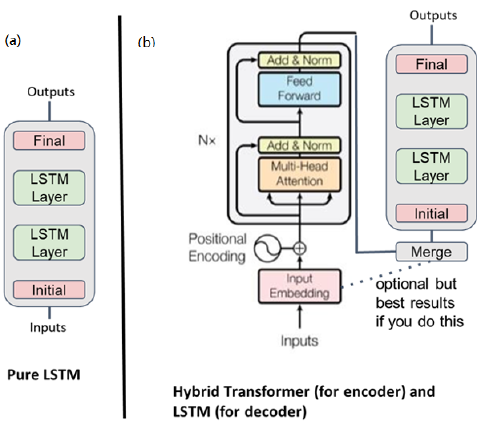
Figure 13. ( a ) Pure LSTM and ( b ) science transformer models discussed in this paper. The former just uses a two-layer recurrent neural network while the latter has an attention-based encoder and an LSTM-based final